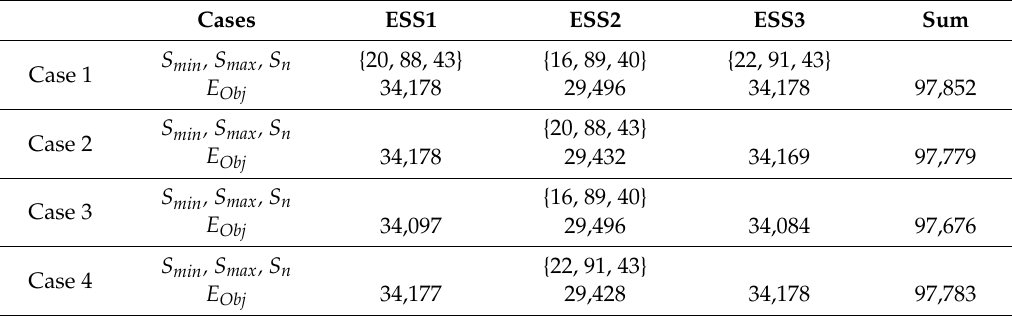
Table 11. SOC operating range and objective function results by